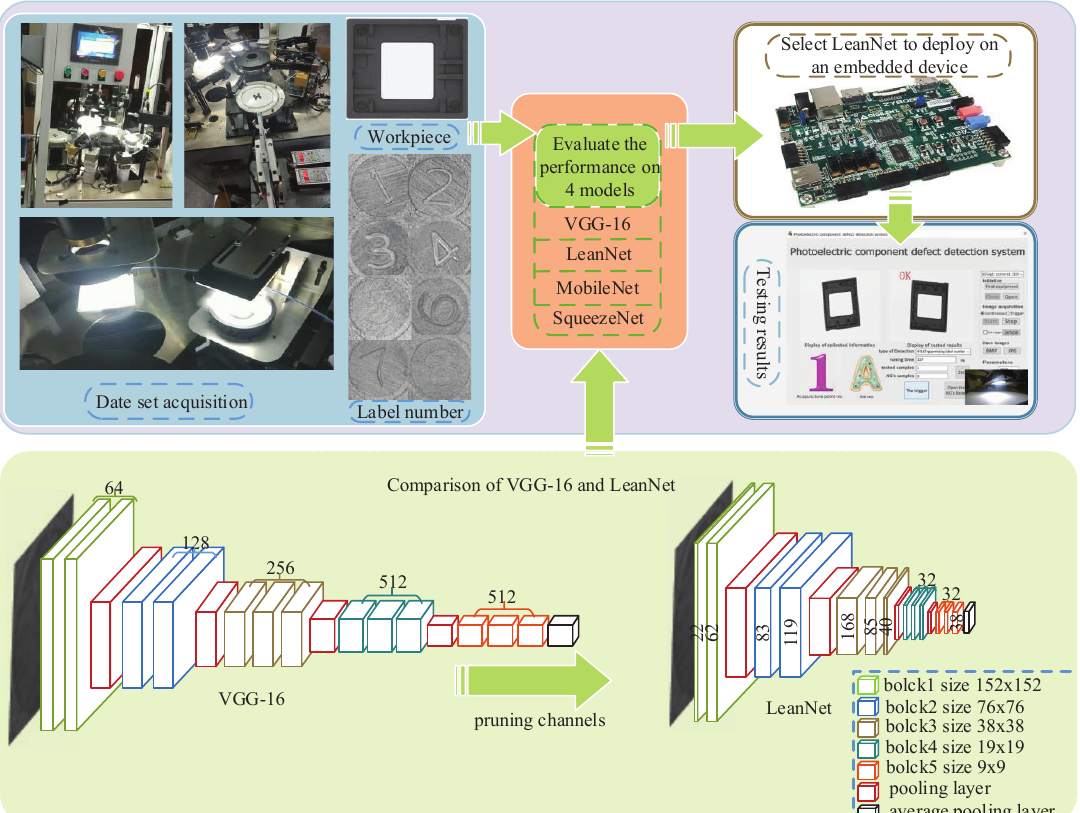
Figure 1. Flowchart of the whole project. The above side shows the process from acquiring the data set to evaluate the model and finally to deploy the model, the below side shows and compares the structure of VGG-16 and LeanNet in detail. The label number part of the flowchart is a collection of label parts on some industrial electronic equipment parts, from 1 to